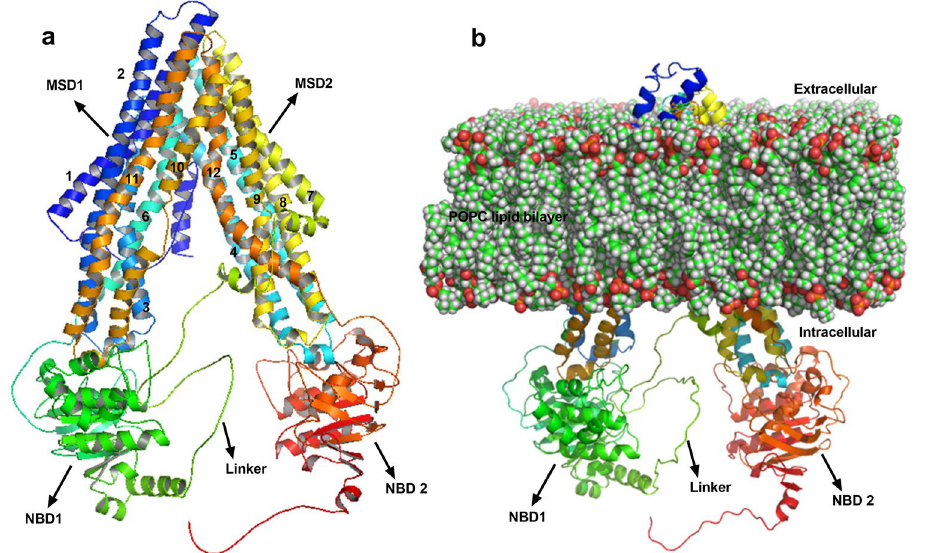
Figure 2. Molecular modeling of human P-gp structure. ( a ) 3D Structure of human P-gp model build by homology modeling using Modeller software. PDB ID: 4F4C is used as template (MSD: membrane spaning domain; NBD: nucleotide binding domain); Transmembrane (TM) helices are denoted by numbers from 1 to 12. ( b ) Human P-gp model embedded in the POPC lipid bilayer, for molecular dynamics simulation; prepared using the CHARMM-GUI